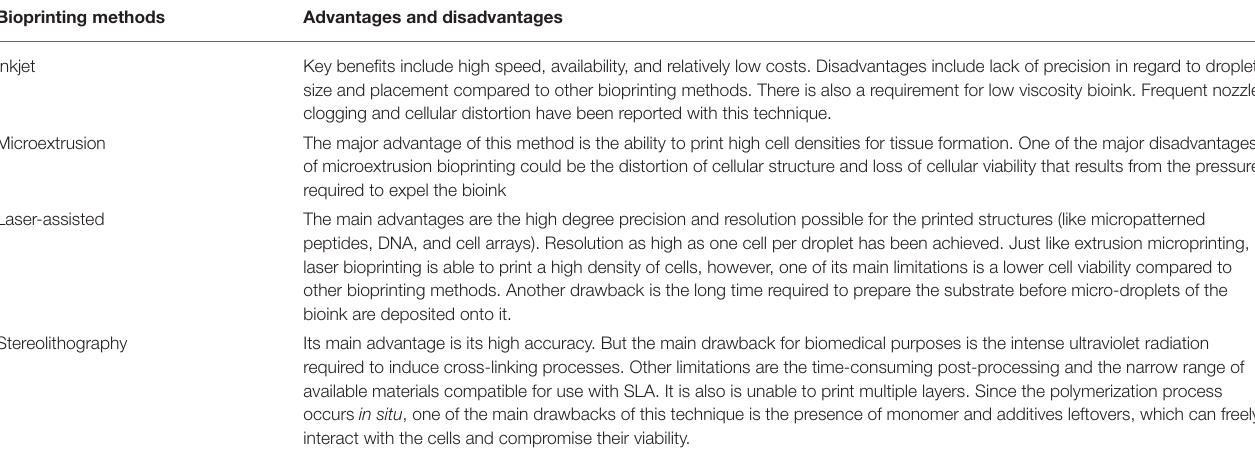
TABLE 1 | Comparative advantages and disadvantages in Bioprinting